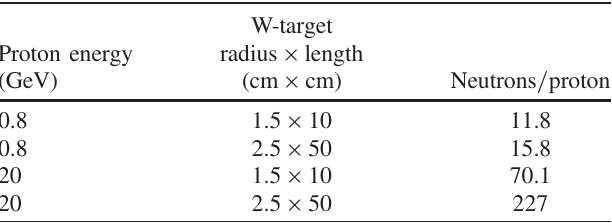
TABLE I. Neutron yield for the four different settings.